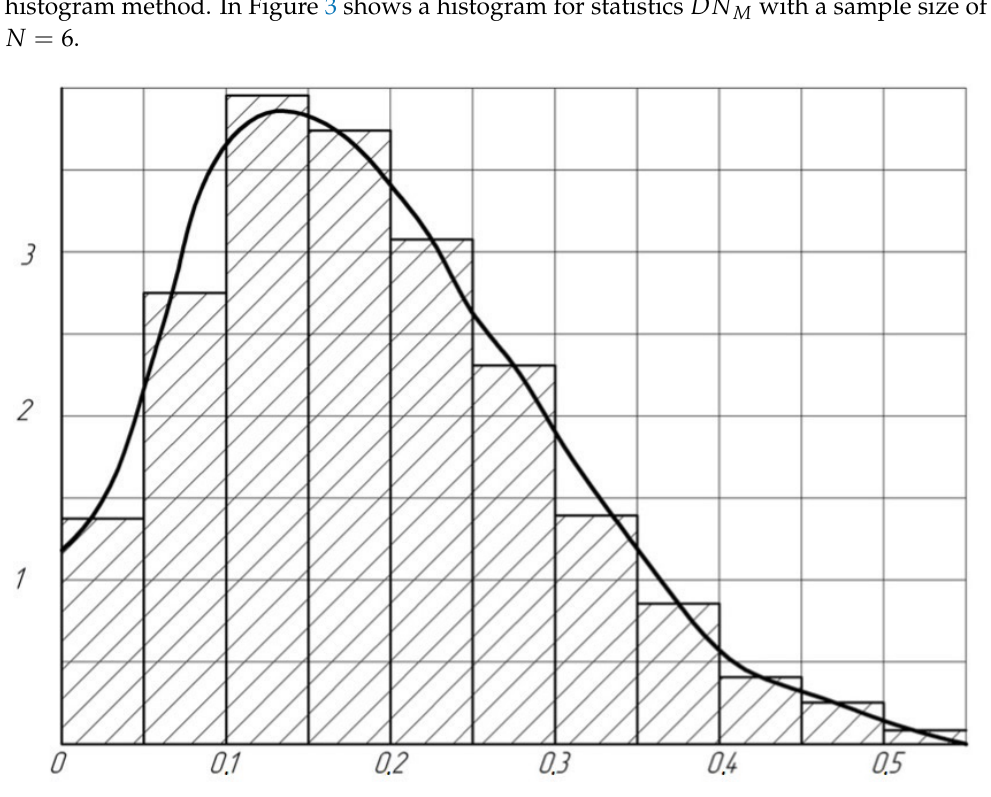
Figure 3. Histogram for statistics DN M